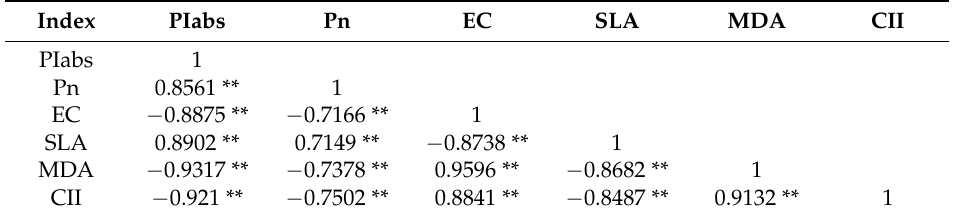
Leakage (EC); Specific leaf area (SLA); Malondialdehyde (MDA). ** means significant difference at p < 0.01. Table 3. Correlations among (PIabs, net photosynthetic rate, electrolyte leakage, specific leaf area, malondialdehyde, chilling index) of 20 genotypes measured at 5/0 °C d/n.